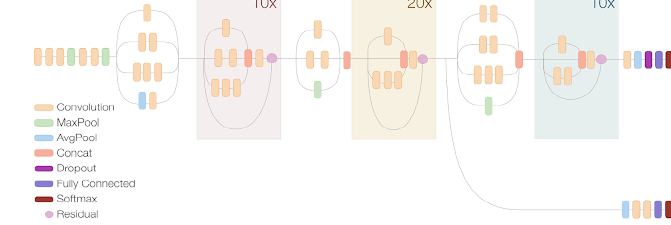
Figure 3. InceptionResnetV2